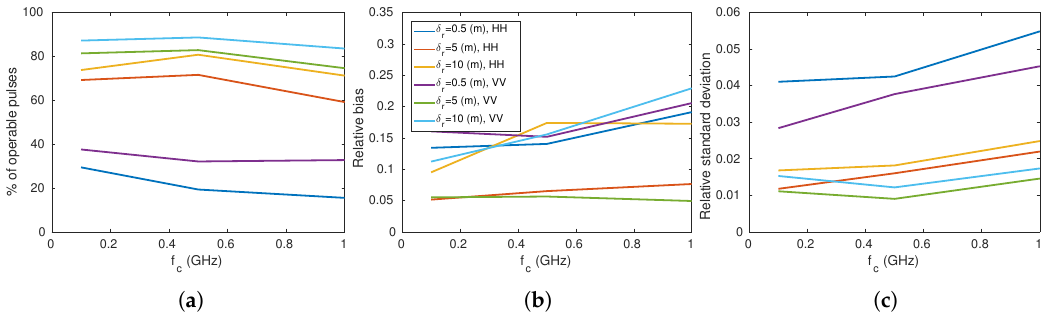
Figure 8. Percentage of operable pulses ( a ), relative bias ( b ) and relative standard deviation ( c ) as a function of the central frequency f c , polarization and resolution δ r .